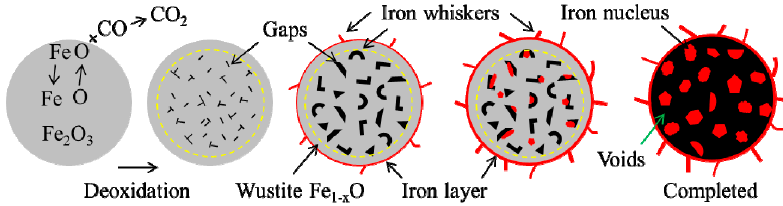
Figure 15. Schematic diagram of the evolution process of a single particle reduction.